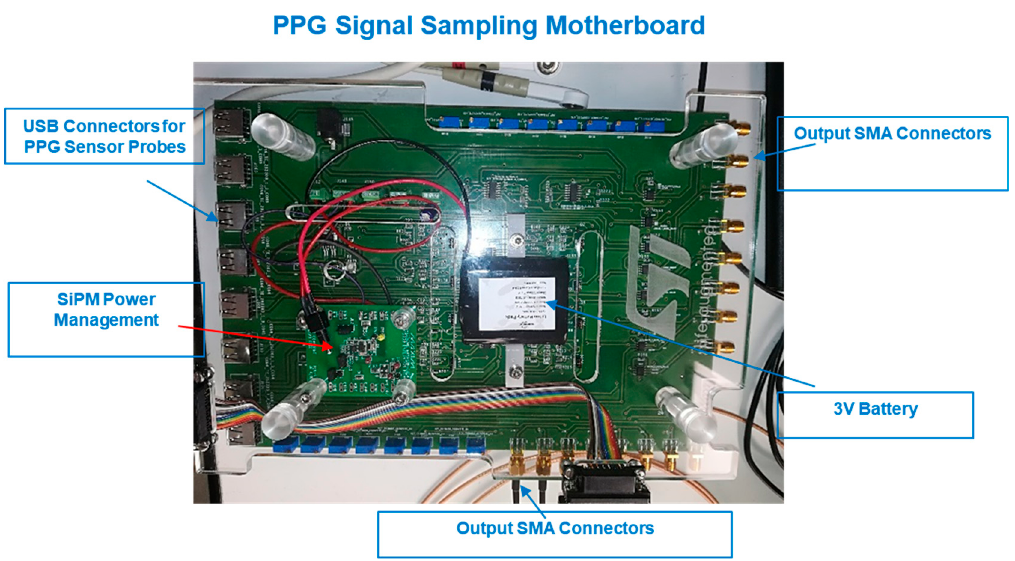
Figure 4. The PPG sampling motherboard.